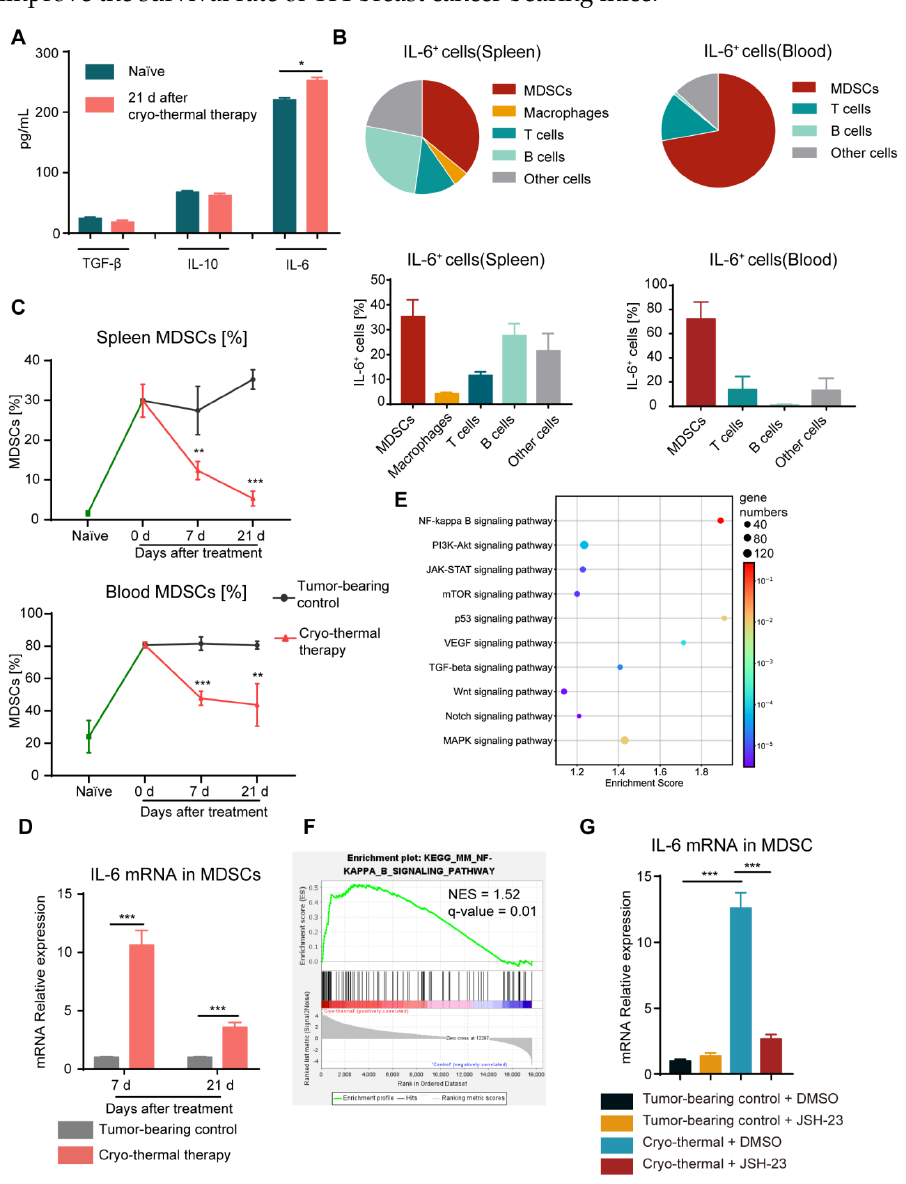
Figure 1. MDSCs activated the NF- κ B signaling pathway to stimulate the production of IL-6. ( A ) The serum levels of TGF- β , IL-10 and IL-6 were determined using ELISA on Day 21 after cryo-thermal therapy. ( B ) The major constituent cells of the IL-6 + cells in the spleen (left) and blood (right) on Day 21 after cryo-thermal therapy were detected by flow cytometry. ( C ) The proportion of MDSCs (CD11b + Gr-1 + ) in the spleen and blood was detected on Day 7 and Day 21 after cryo-thermal therapy. ( D ) The expression of IL-6 in MDSCs from the spleen at different time points after cryo-thermal therapy was detected by quantitative real-time PCR (qRT-PCR). n = 4 for each group. ( E ) Bubble map of KEGG enrichment signaling pathway in splenic MDSCs. ( F ) NF- κ B signaling pathway in splenic MDSCs, NES represented normalized enrichment score, n = 3 for each group. ( G ) The mRNA level of IL-6 in MDSCs from the spleen with or without treatment with JSH-23 (10 µ M). n = 4 for each group. * p < 0.05, ** p < 0.01, *** p < 0.001. Data were analyzed using one-way ANOVA (comparing three or more experimental groups) and two-sided Student’s t -test (comparing two experimental